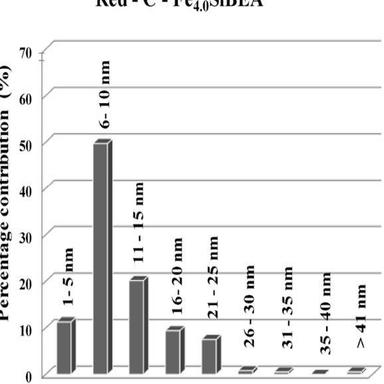
TEM image and histogram of nanoparticles for a) Red-C-Fe4.0HAlBEA and b) Red-C-Fe4.0SiBEA after calcination at 500 ◦C for 3 h and reduction at 900 ◦C.